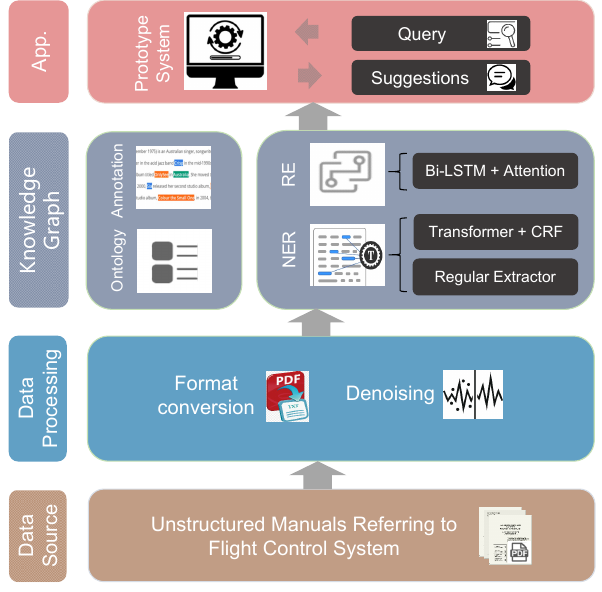
Figure 1. System